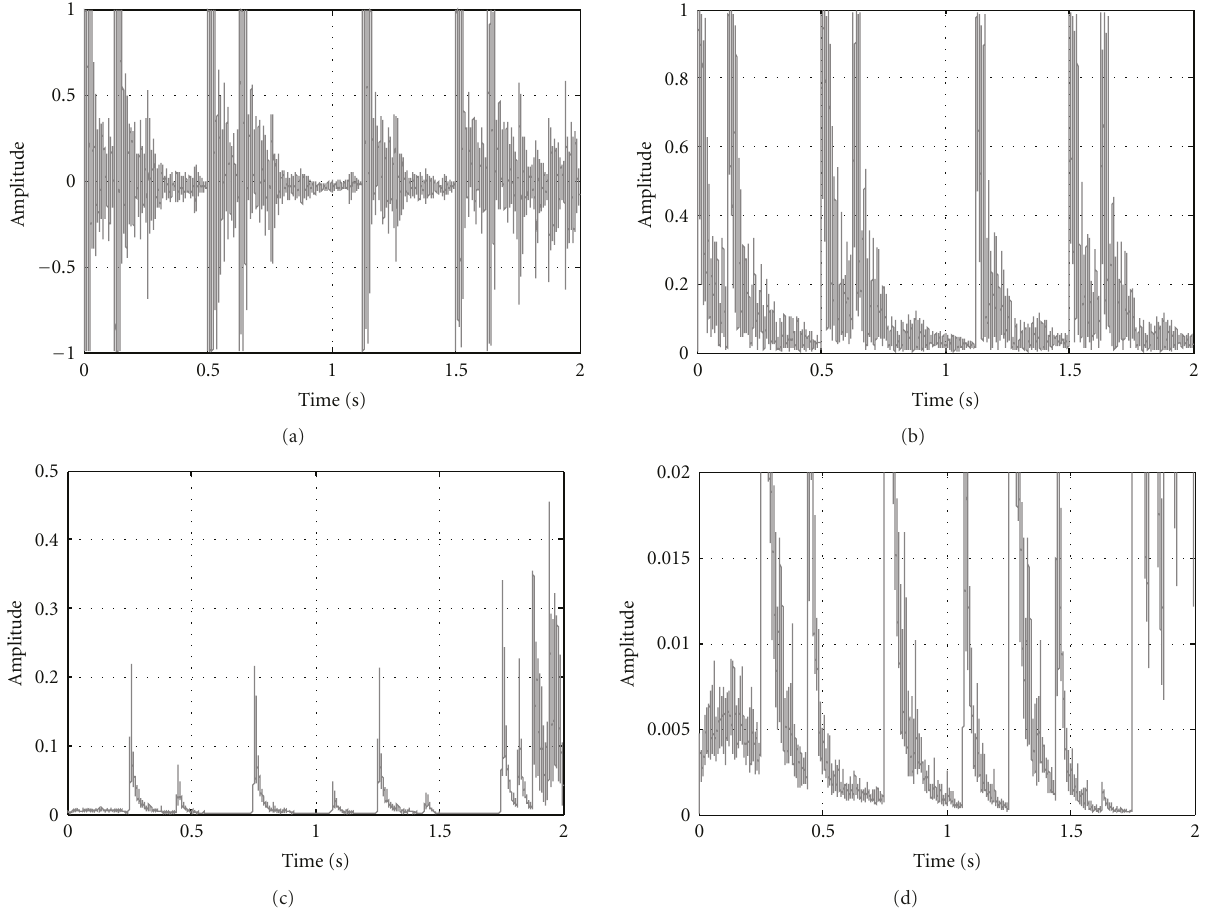
Figure 1: An example kick drum recording, (a) is a noisy microphone signal which includes kick drum and bleed, (b) shows the amplitude envelope of the kick drum contained within the noisy signal, and (c) and (d) show the amplitude envelope of the bleed contained within the noisy signal. Part (d) has reduced limits on the y -axis to show cymbals and hi-hats in the bleed